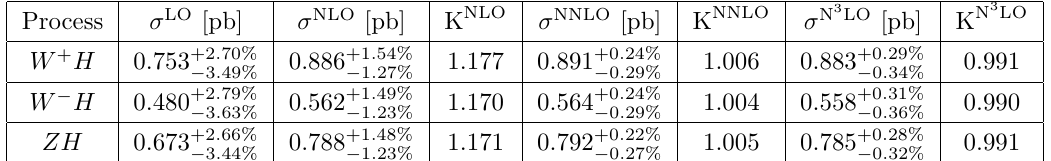
= m + m . The PDF 0 V H